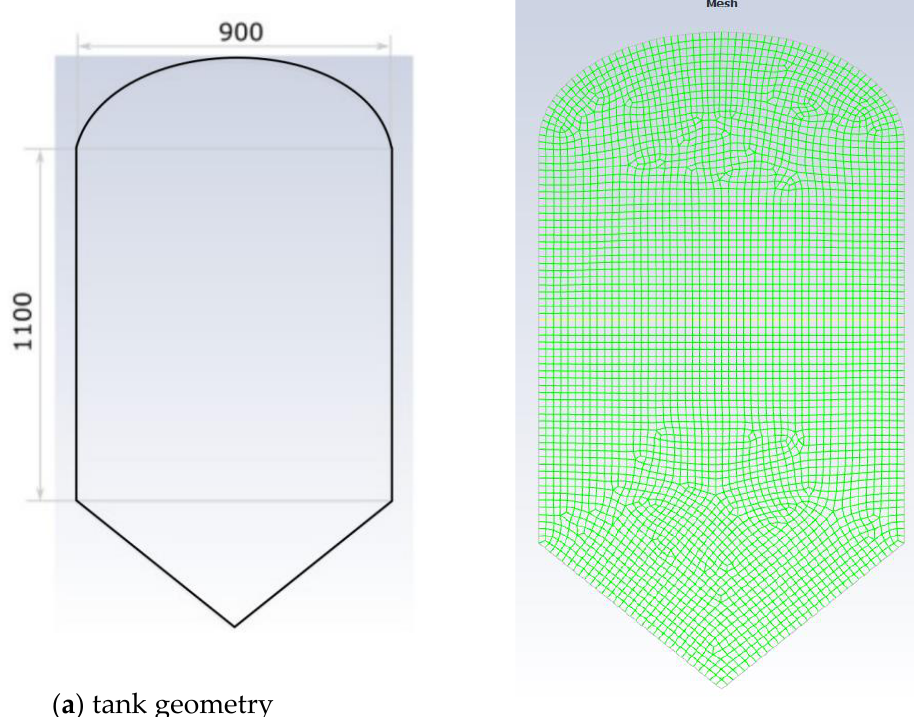
Figure 2. Geometry of the modeled tank ( a ) and meshed geometry ( b ).